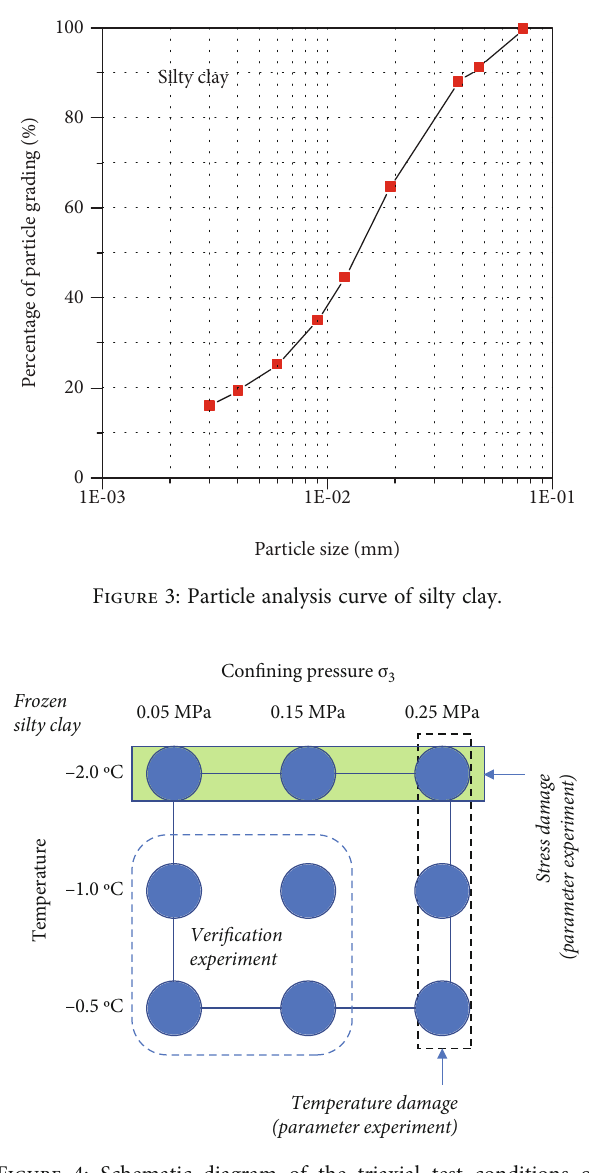
Figure 4: Schematic diagram of the triaxial test conditions of frozen silty